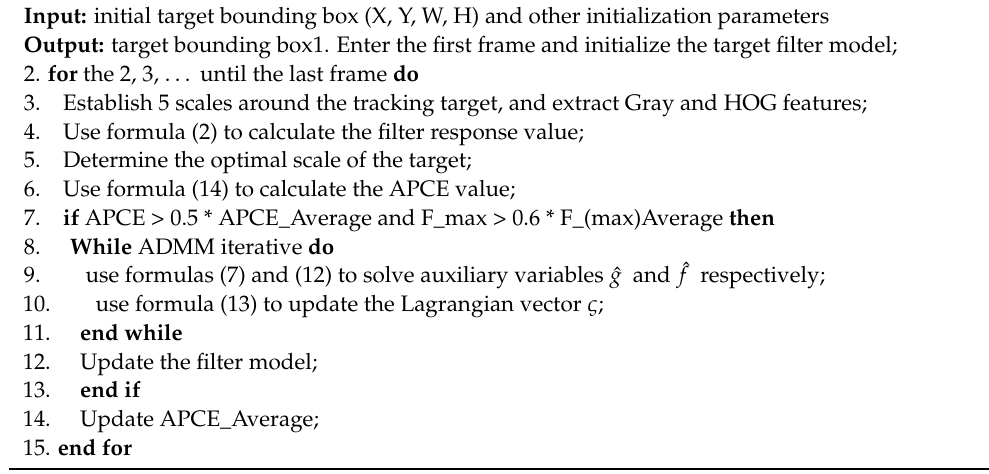
Algorithm 1: Fast Tracking Algorithm Based on Spatial Regularization Correlation